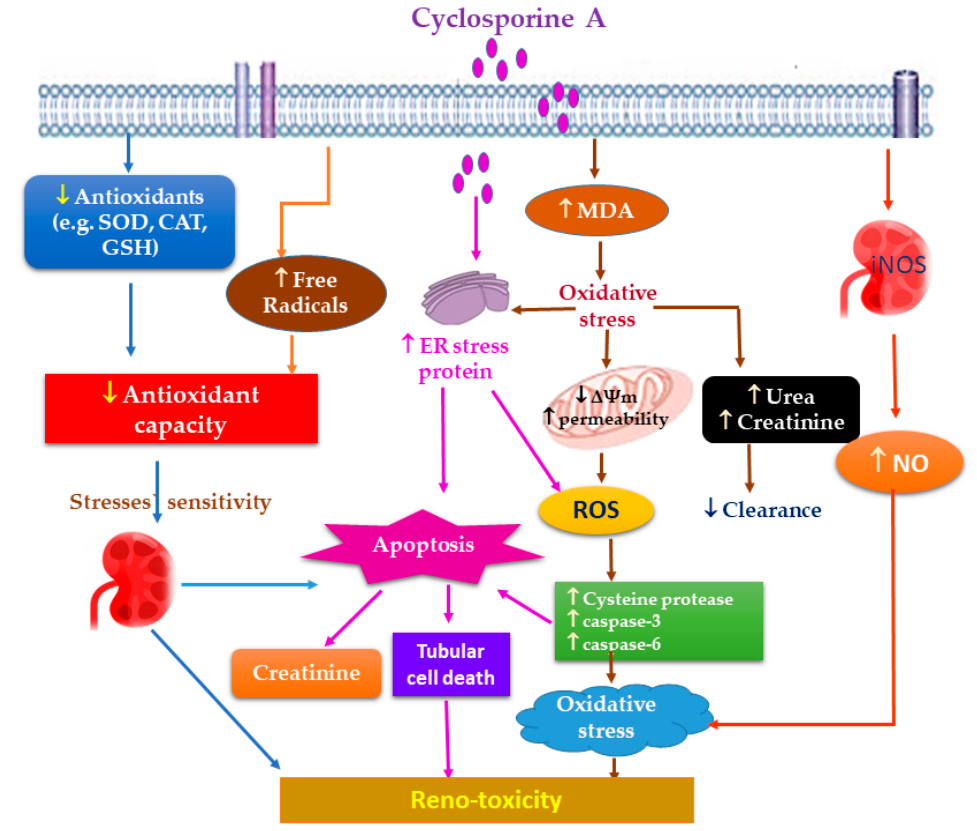
Figure 2. Proposed mechanisms of CA oxidative stress-induced reno-toxicity.